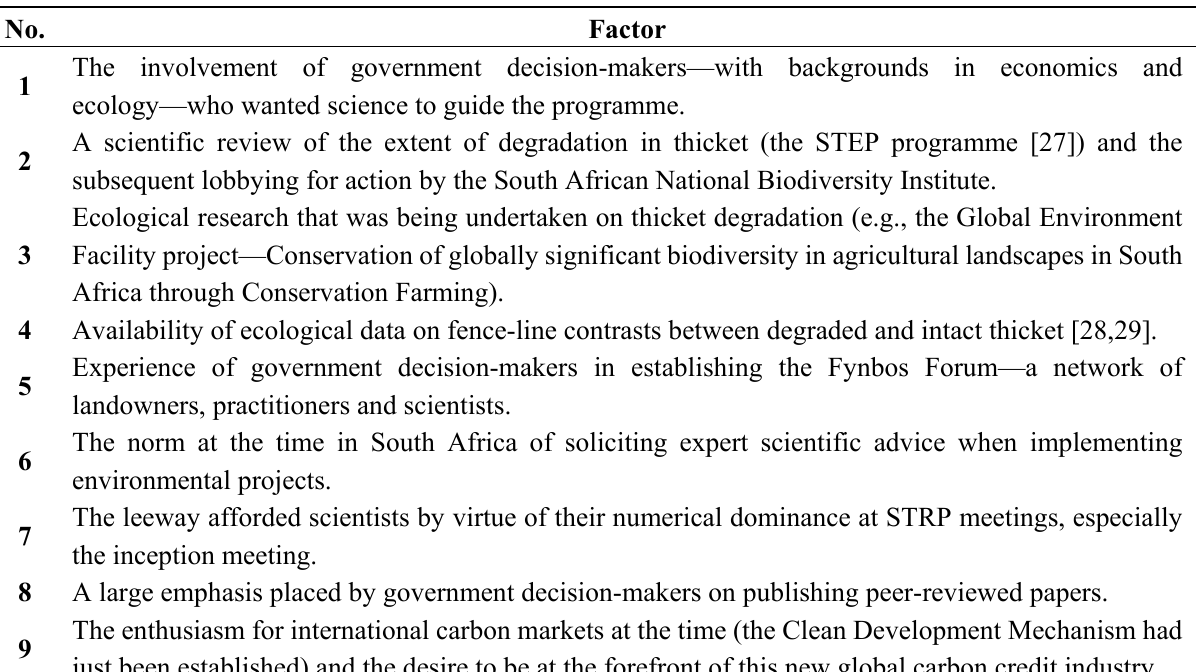
Table 1. Institutional factors influencing the strategic decisions of STRP stakeholders. No. Factor of government decision-makers—with backgrounds in economics